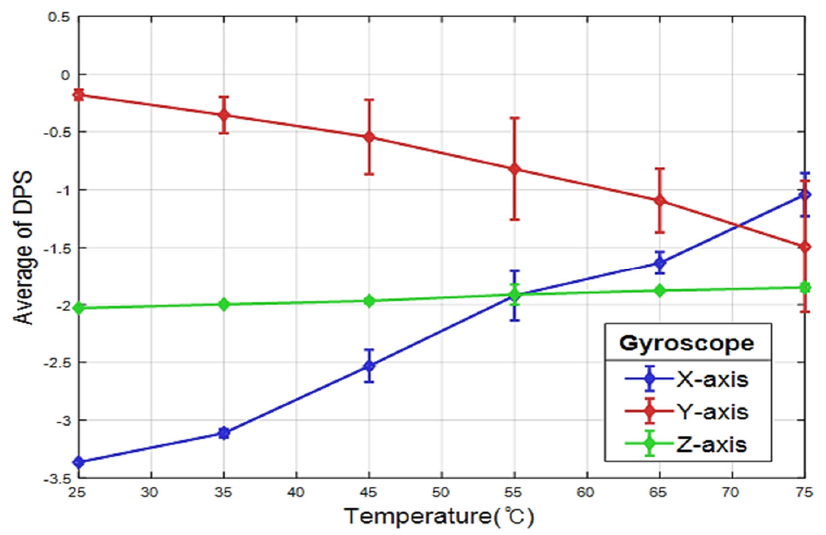
Figure 10. Averages and standard deviations of the measured values by temperature in the X-, Y-, and Z-axes of the gyroscope sensor.